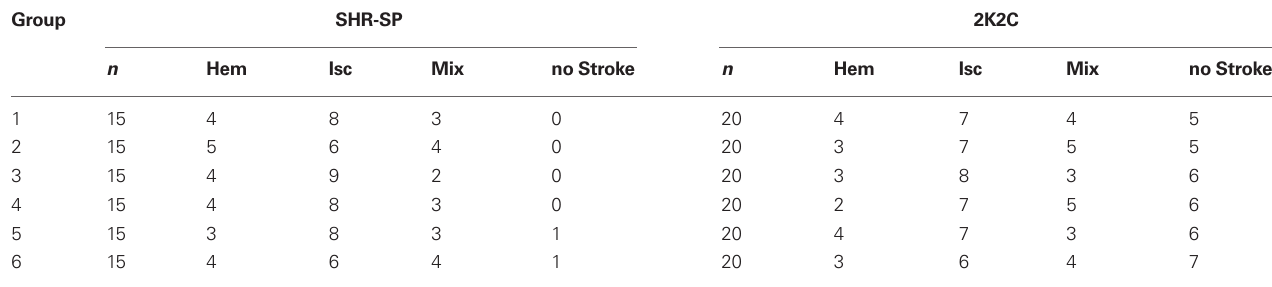
Table 3 | Occurrence of brain lesions in different groups of SHr-SP and 2K2C rats. Group SHr-SP